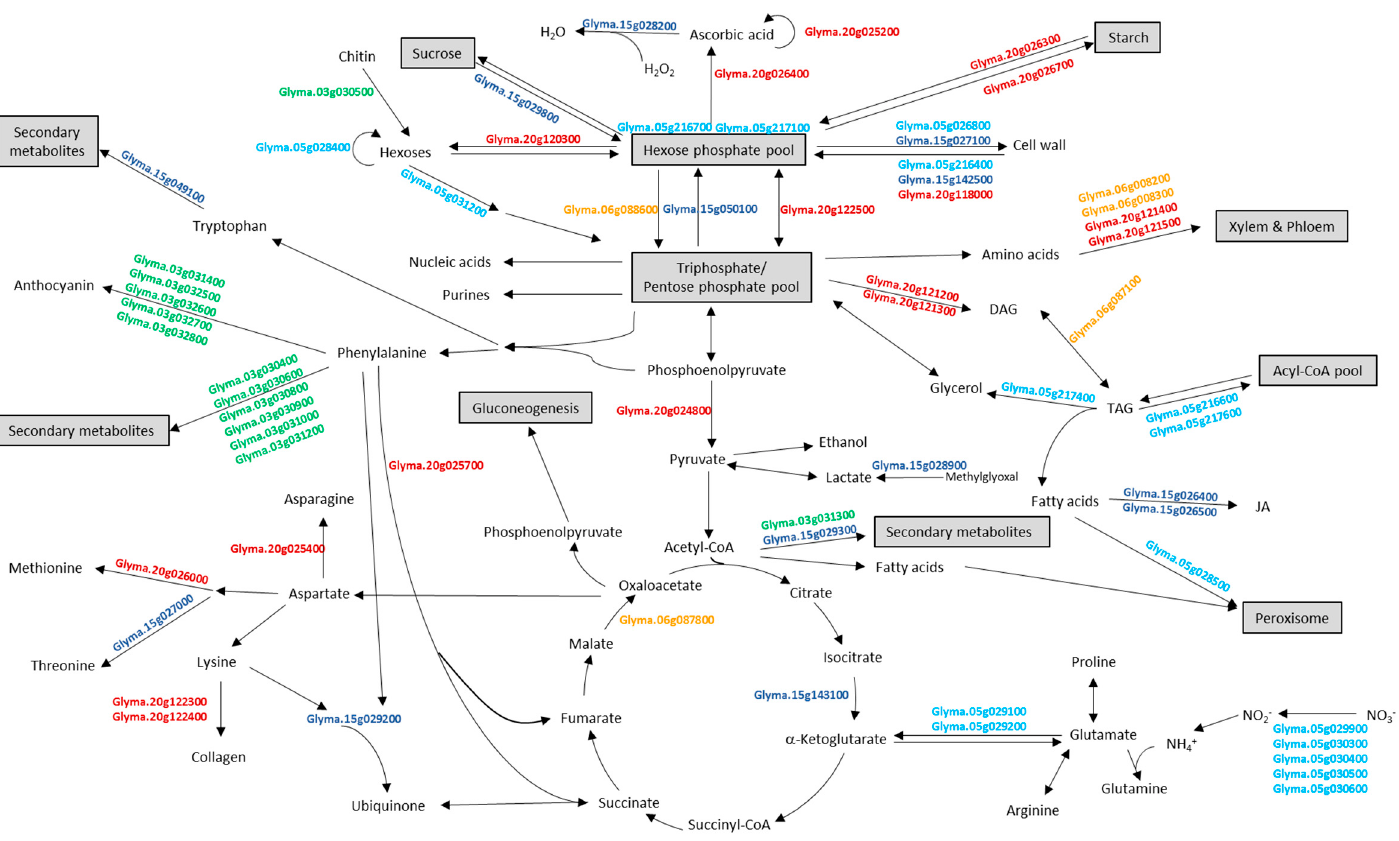
Figure 2. Overview of metabolic processes involved by positional and functional candidate genes. Candidate genes names from Glyma.Wm82.a2.v1 (Gmax2.0) (available online: http://soybase.org) are shown in bold and color-coded by chromosomes.